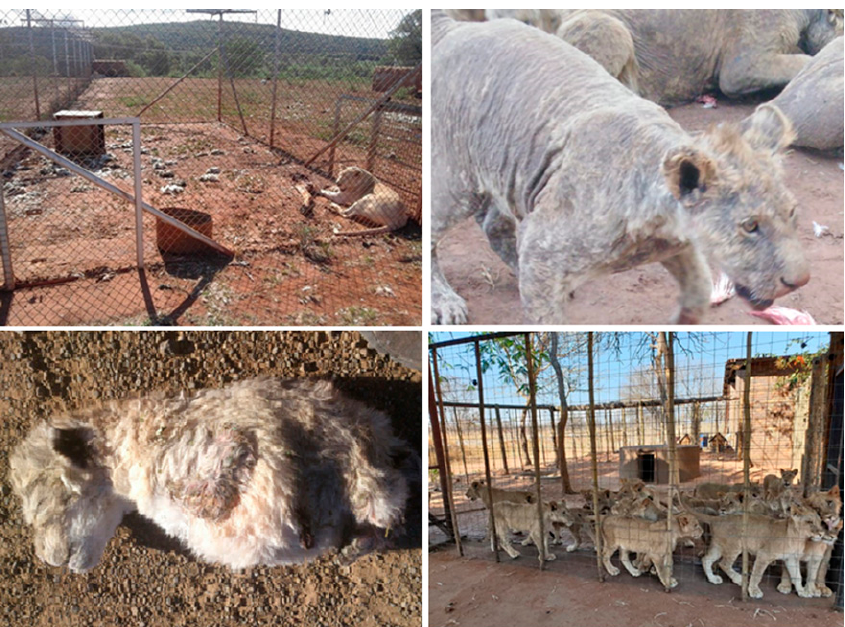
Figure 1. Environments provided for lions at commercial captive breeding facilities in South Africa are frequently reported as low welfare, involving large numbers of lions, often in poor physical condition and in over-crowded spaces. ( Top left ) Lioness housed in an enclosure with fecal matter and decaying carcasses. ( Top right ) Lions with little to no fur left as a result of severe and untreated mange. ( Bottom left ) Lion cub born with severe deformities, likely due to inbreeding. ( Bottom right ) Lions housed in overcrowded conditions. Images copyright Blood Lions.